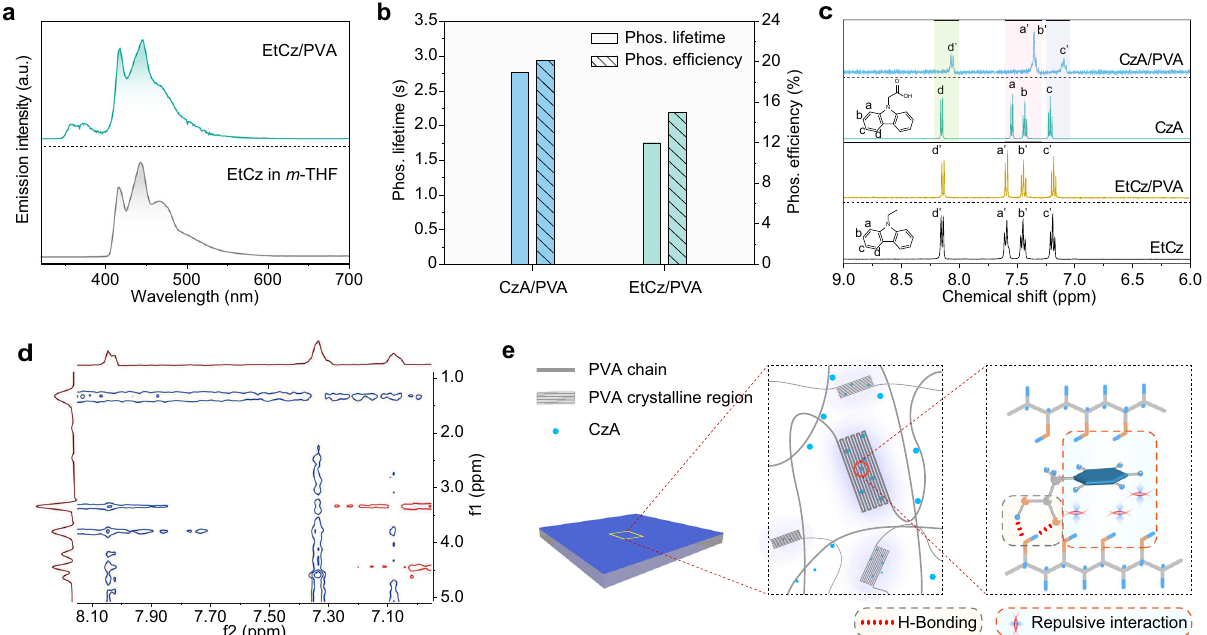
NMR spectra of the emitters within/without PVA matrix at 293K. d Partial NOESY NMR spectrum of CzA/PVA in DMSO- d 6 at 293K. e A conceivable mechanism for UOP of the emitters in PVA fi lm.